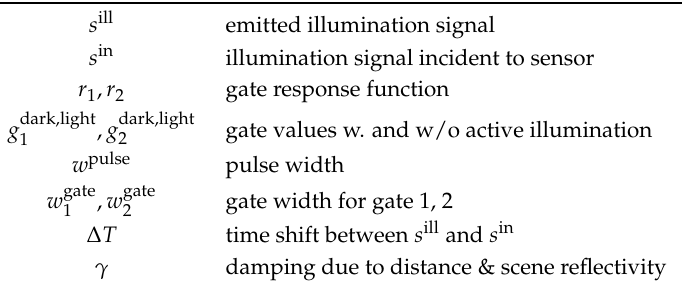
Table 1. Symbols used for pulse-based